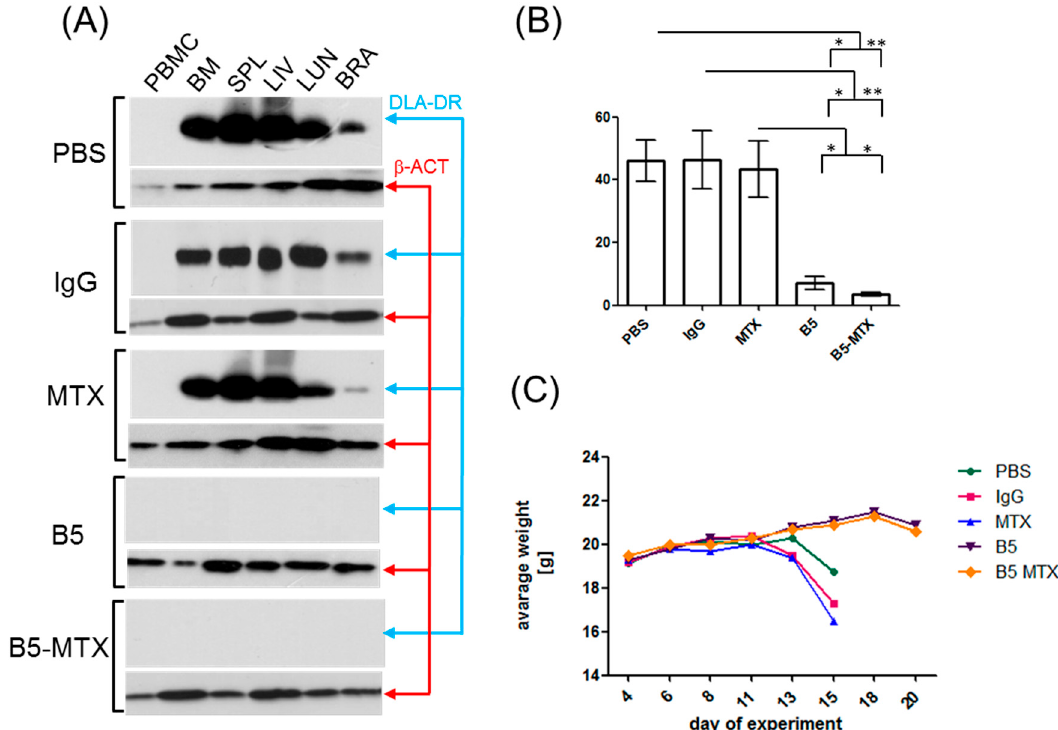
Figure 4. Analysis of tumor cell spread and body weight loss in CLBL-Luc tumor-bearing mice. ( A ) Protein lysates were obtained from the following organs / tissues of tumor-bearing mice: peripheral blood mononuclear cells (PBMC), bone marrow (BM), spleen (SPL), liver (LIV), lung (LUN), brain (BRA). Admixture of CLBL1-Luc cells in the above organs / tissues, reflecting tumor burden, was evaluated by Western blotting with anti-DLA-DR antibody. Protein loading was controlled with an anti-beta actin antibody ( β -ACT) ( B ) Cell suspensions of bone marrows were prepared from mice treated with PBS ( n = 8), IgG ( n = 7), MTX ( n = 8), B5 ( n = 5) and B5-MTX ( n = 5) and assessed for CLBL1-Luc cell content by flow cytometry with an anti-DLA-DR antibody, E11. ( C ) The average body weights of mice from the indicated experimental groups ( n = 8 mice per group except for B5, n = 10 mice per group) were plotted. Statistically significant di ff erences between the groups were marked with an asterisk (*** p < 0.001, ** p < 0.01).